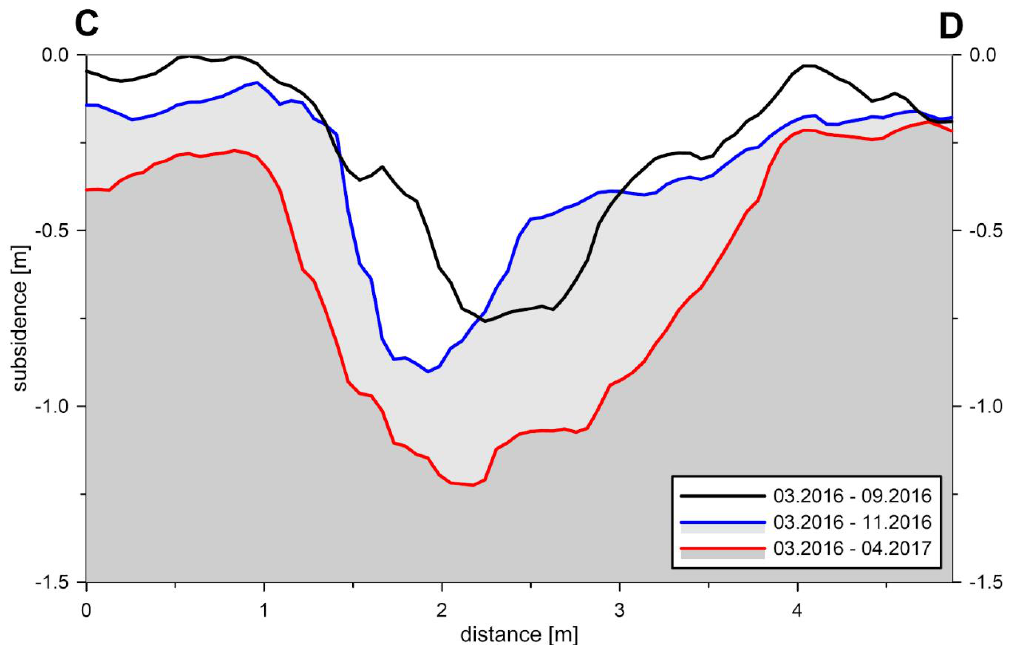
Figure 10. Subsidence profiles along a C–D discontinuous deformation based on results obtained using UAV photogrammetry (Piekary site). UAV photogrammetry (Piekary